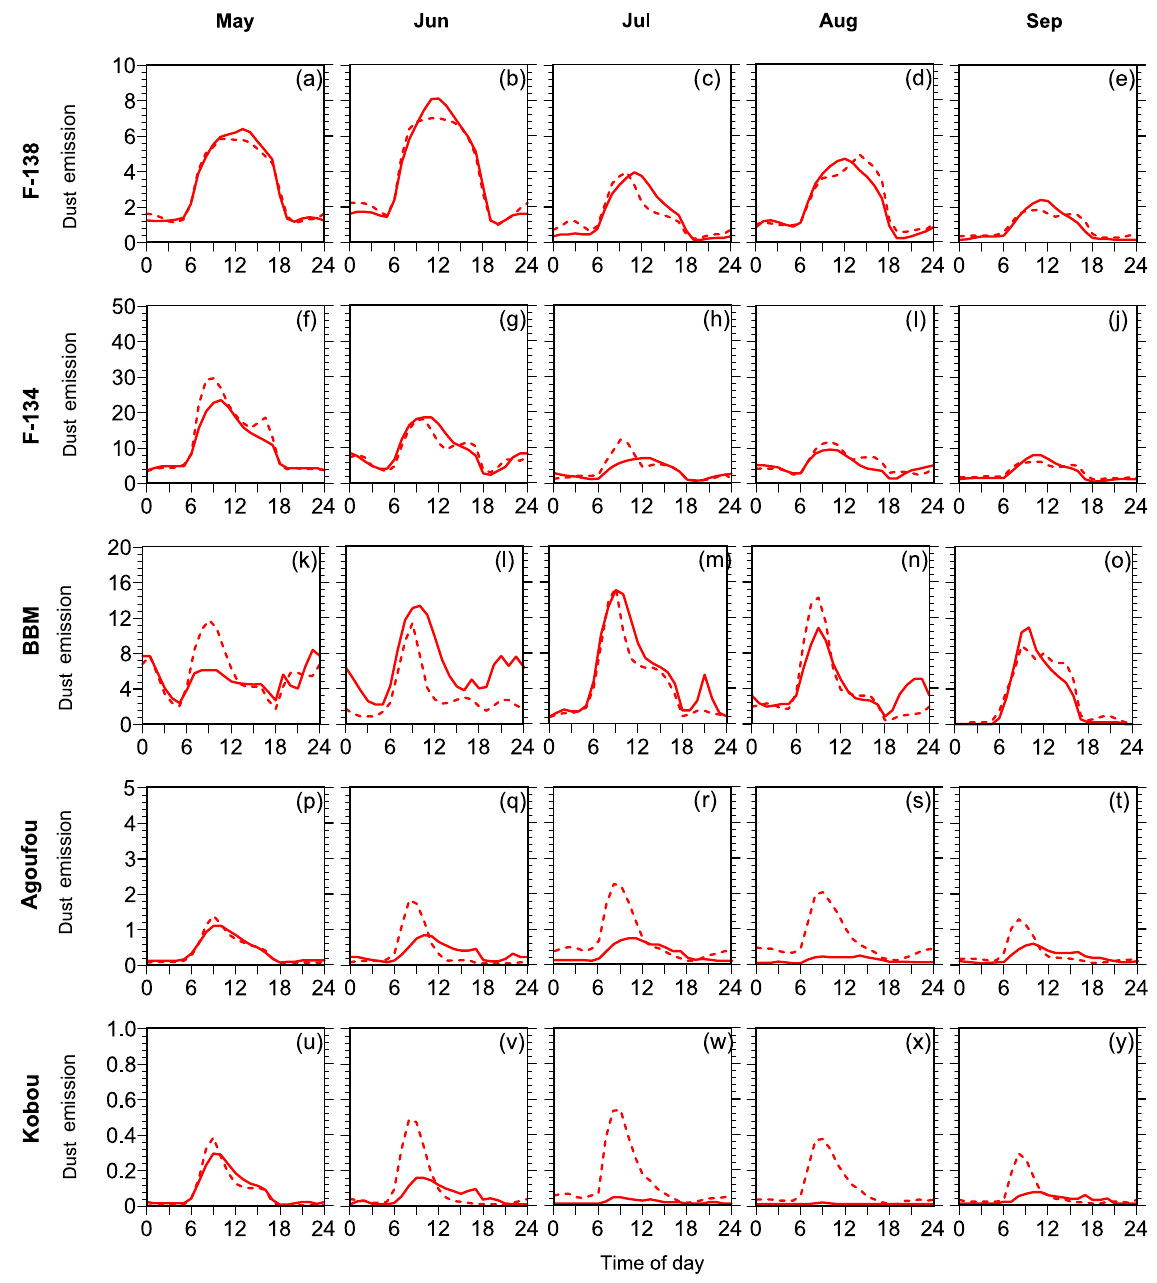
Figure 10. Monthly mean (May–September) diurnal cycles in dust emission (in µgm 2 s − 1 ) for Fennec and AMMA stations (shown on Fig. 1) for 12km models with explicit (12E, red solid line) and parameterised (12P, red dashed line) convection. (a–e) Fennec station F- 138, (f–j) Fennec station F-134, (k–o) Fennec supersite at Bordj Badji Mokhtar, (p–t) AMMA CATCH site at Agoufou and (u–y) AMMA CATCH site at Kobou. Note the changing vertical scale for each